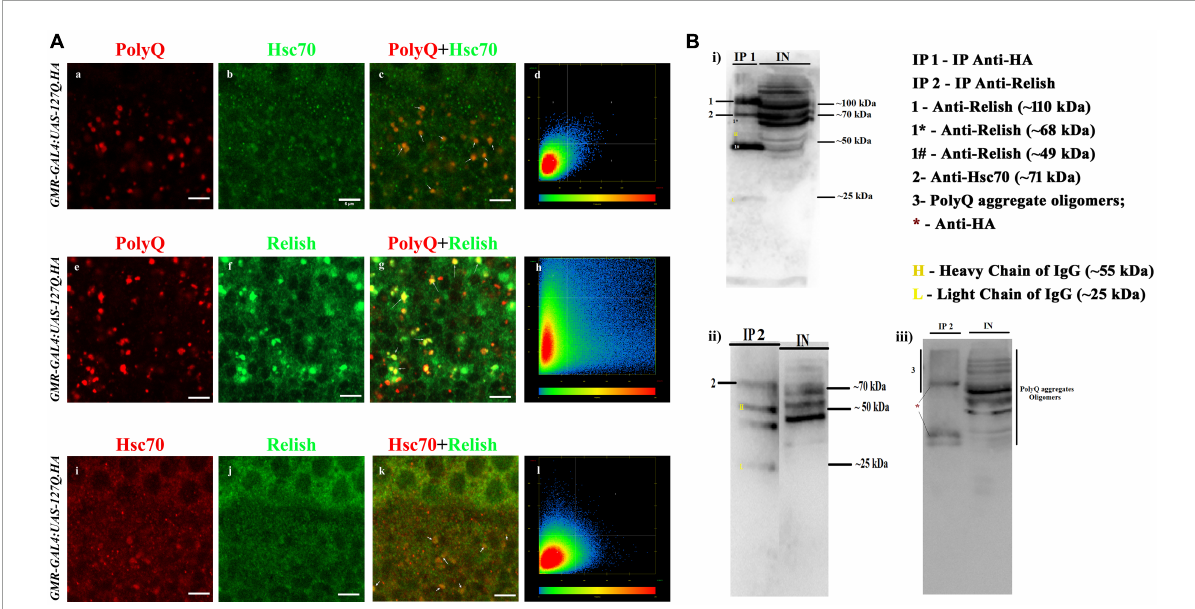
FIGURE5 PolyQ aggregates colocalized and coprecipitated with Hsc70 and Relish. (A) The panel shows the section image of the eye imaginal disc of GMR-GAL4 UAS 127Q third instar larvae. (a–d) Co-staining of the PolyQ aggregates (in red) and Hsc70 (in green) shows that PolyQ aggregates and Hsc70 colocalize with each other; the arrow demarcates the colocalized regions in yellow (scale bar 5 µ m). (e–h) Co-staining of the PolyQ aggregates (in red) and Relish (in green) shows that PolyQ aggregates colocalize with Relish. Arrow demarcates the colocalized regions in yellow (scale bar 5 µ m). (i–l) Co-staining of Hsc70 (in red) and Relish (in green) co-stained in the polyQ- expressing eye disc shows the colocalization (in yellow), which is marked by the arrow (scale bar 5 µ m). (B) Immunoblot panels illustrated the presence of the interacting proteins in the co-IP elute (denoted as IP) from the crude protein sample (demarcated as IN, means input) of GMR-GAL4:UAS-127Q . HA background. (i) Western blot shows the presence of Relish and Hsc70 in the IP1 sample after precipitation of PolyQ aggregate using anti-HA and the expression pattern in input. Images ii and iii are immunoblot showing the presence of Hsc70 and PolyQ aggregates, respectively, in the IP2 sample after precipitation of Relish using anti-Relish, and the expression pattern was compared with the input sample. IP 1—eluted protein sample after pull-down with anti-HA; IP 2—eluted protein sample after pull-down with anti-Relish; IN—crude protein sample of GMR-GAL4:UAS-127Q.HA genetic background; 1- whole-Relish protein ( ∼ 110 kDa), 1* donates a faint band of N-terminal Relish ( ∼ 68 kDa), and 1# denotes a sharp band of C-terminal Relish ( ∼ 49 kDa); 2—Hsc70 ( ∼ 71 kDa); 3—PolyQ aggregates oligomers detected by anti-HA along with *representing the bands of anti-HA; H and L denote heavy chain ( ∼ 55 kDa) and light chain ( ∼ 25 kDa) of